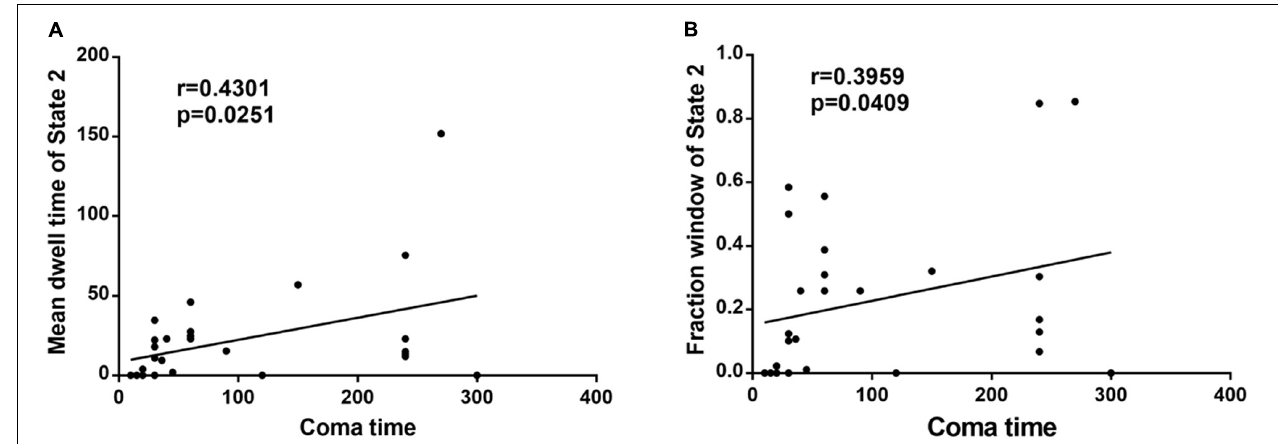
FIGURE 2 | (A) The mean dwell time of State 2 is positively associated with coma time in acute CO poisoning patients. (B) The fraction window of State 2 is positively correlated with coma time in acute CO poisoning patients.